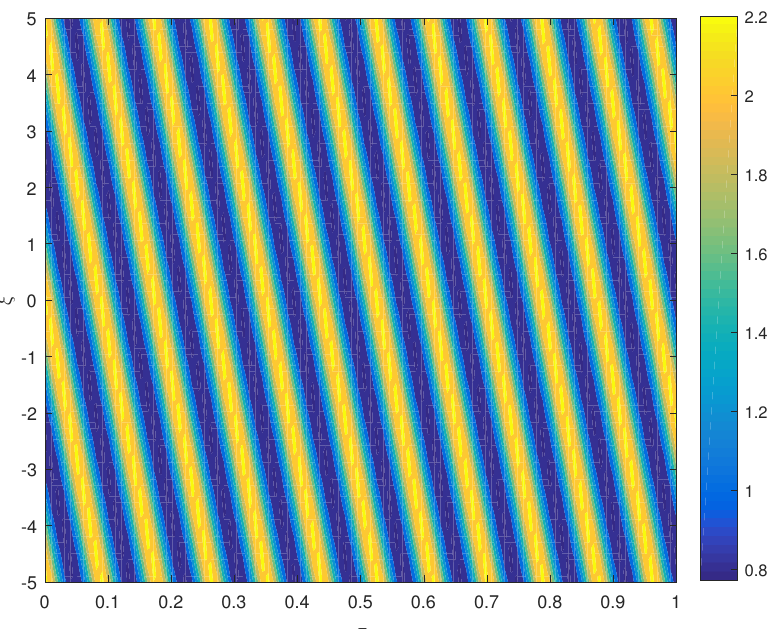
Figure 16. The contour plot of quasi-soliton for MKdV